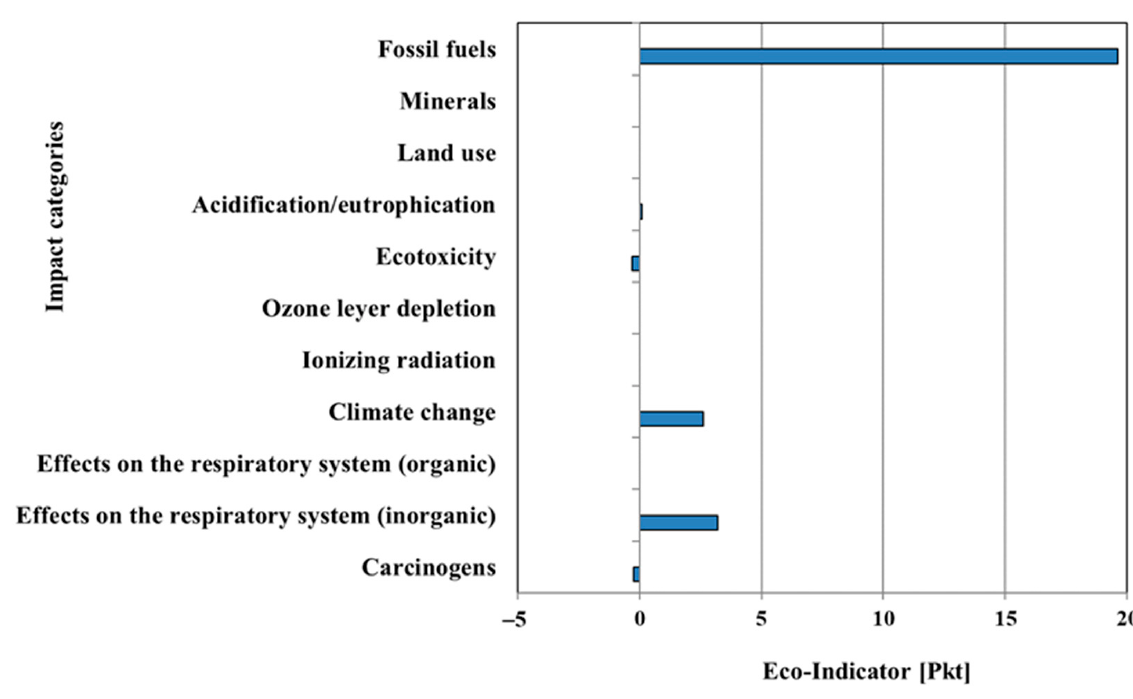
Figure 1. Results of LCA analysis for a coal-fired CHP plant operating in Poland (on the base of [94,95]).